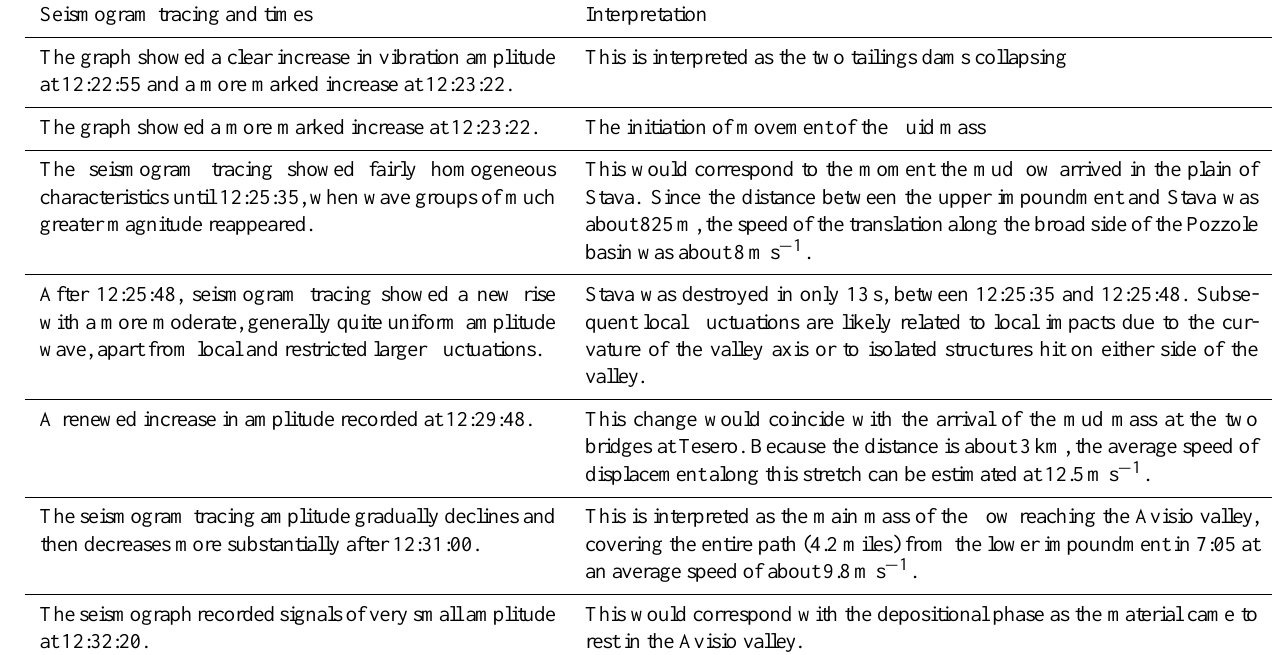
Table 2. Analysis of the time intervals from the first vibrations to the final deposition of solid-liquid mixture in the Avisio Valley. Seismogram tracing and